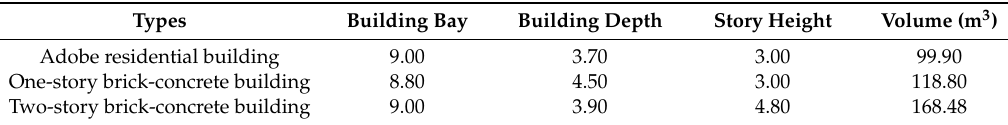
Table 8. Model simplification data for di ff erent residential buildings (m).